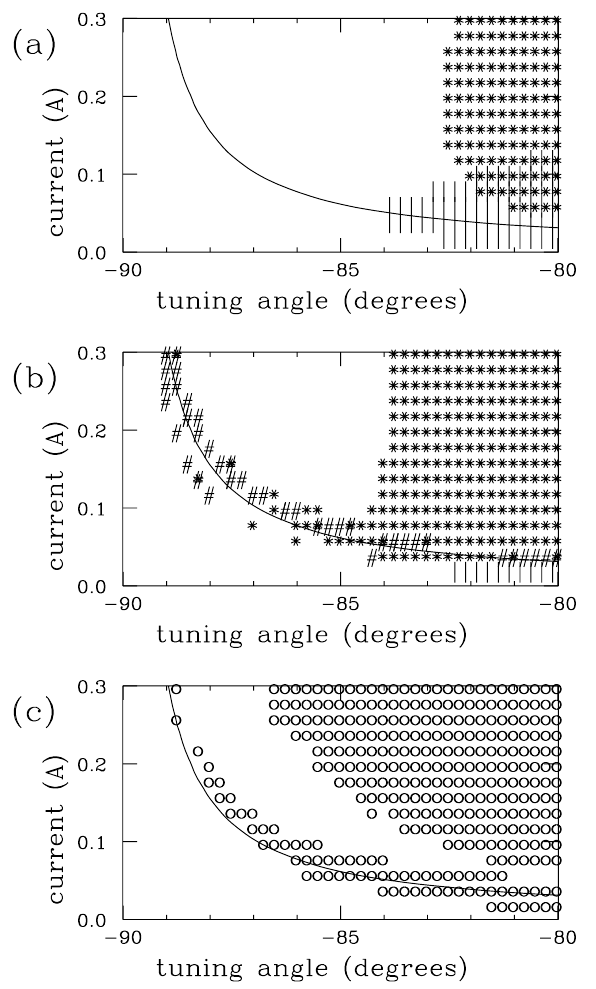
FIG. 5. Robinson instabilities are predicted without considera- tion of mode coupling, for passive Landau-cavity operation with the LF20 low-emittance lattice and a fundamental rf voltage of 50 kV. Vertical line: dipole instability; *: quadrupole instability. (b) Dipole-quadrupole mode coupling is included in Robinson instability predictions. Vertical line: coupled-dipole instability; *: coupled-quadrupole instability; #: fast mode-coupling insta- bility. (c) Instabilities observed in 500 000 turn simulations.